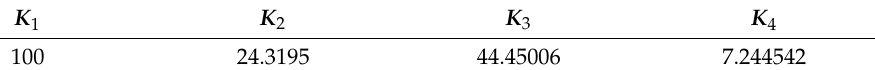
Figure 52. Rotor direct axis current average using DCI at 90% dip. Table 10. LQR controller gains at 90% dip.